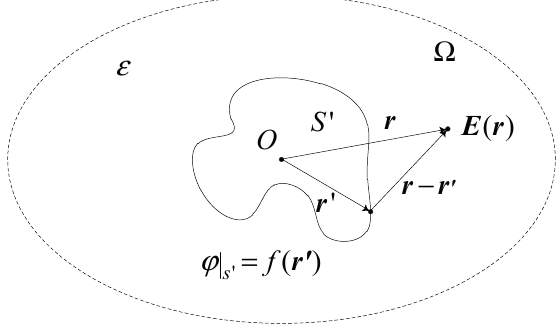
Figure 2. Calculation for the electric field distribution of a charged body.